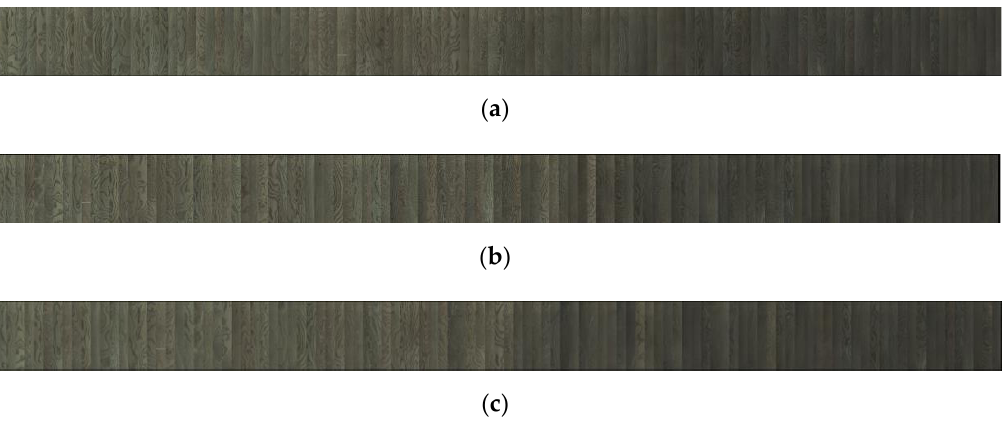
Figure 15. Sorting results on the whole dataset. ( a ) LGBM. ( b ) Densenet121. ( c ) Vision Trans- former.